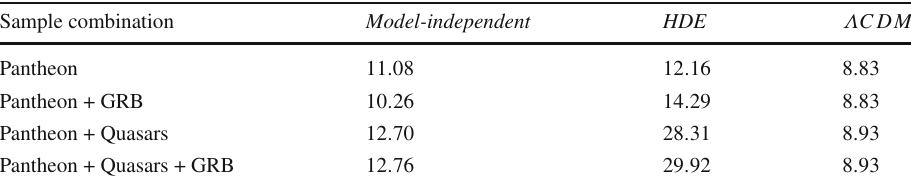
Table 6 The χ 2 values for H model-independent cosmography approach, HDE and Λ CDM scenarios